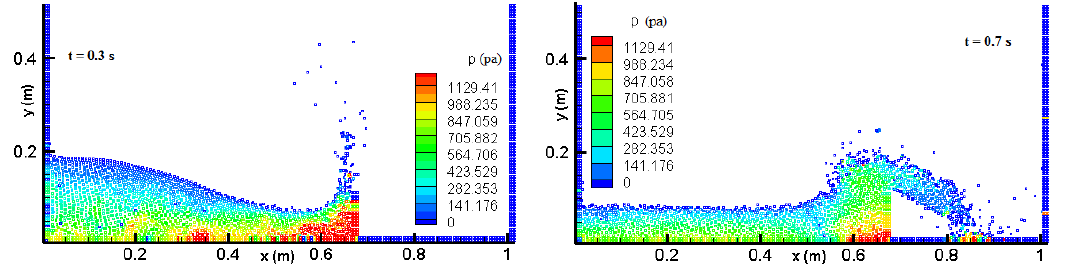
Figure 4 calculated Pressure contours by the ISPH model in 0.3 s and 0.7 s for the dam-break flow in contrast to a rigid obstacle test case.